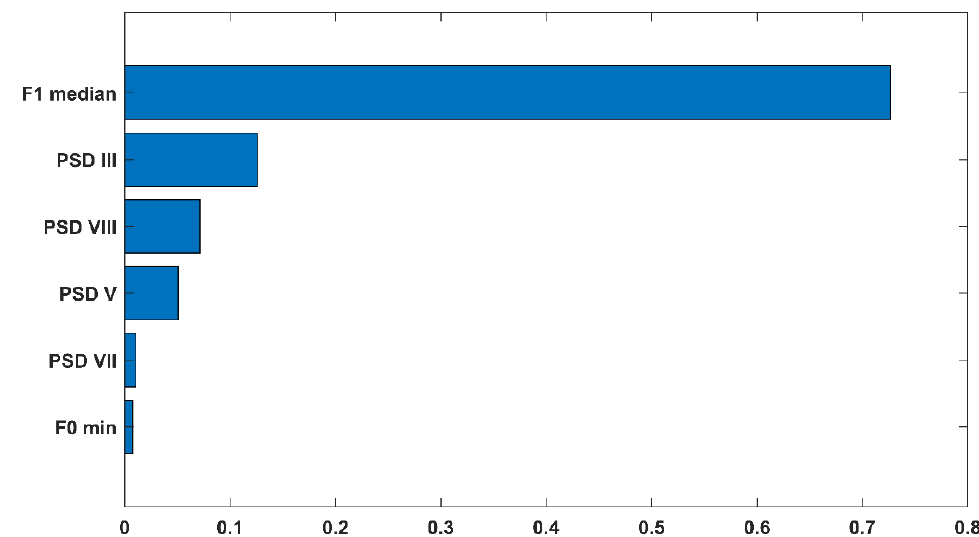
Figure 4. Acoustical parameters sorted in descending order on the basis of the ratio between their weight and the total weight for the B index.